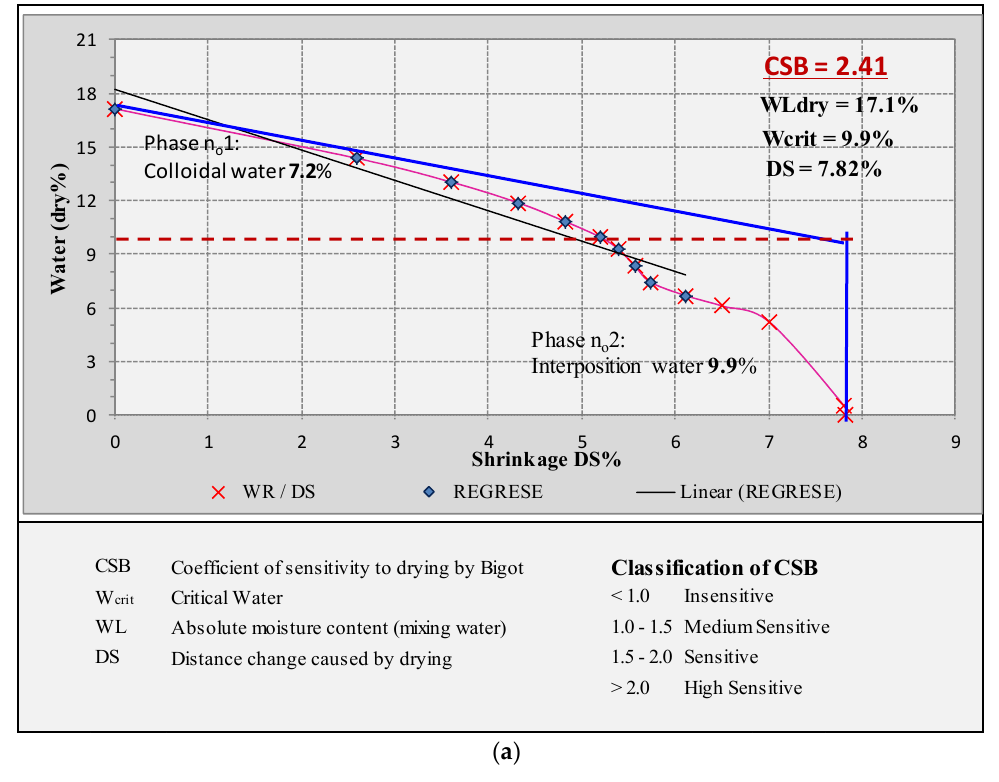
Figure A3. Firing cycle of DM, HM, and SM. Table A1. The concentrations of soluble salts in DM, HM, and SM clays.